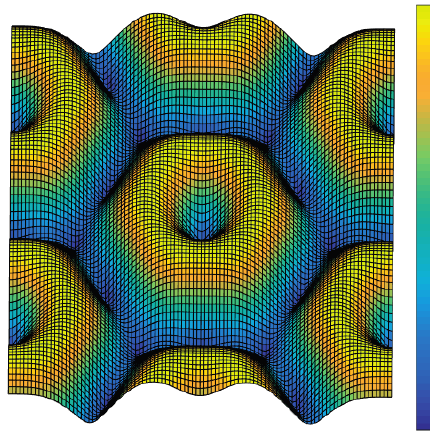
Figure 7. Magnitude of the systematic centroid error with respect to the entrance position of the starlight